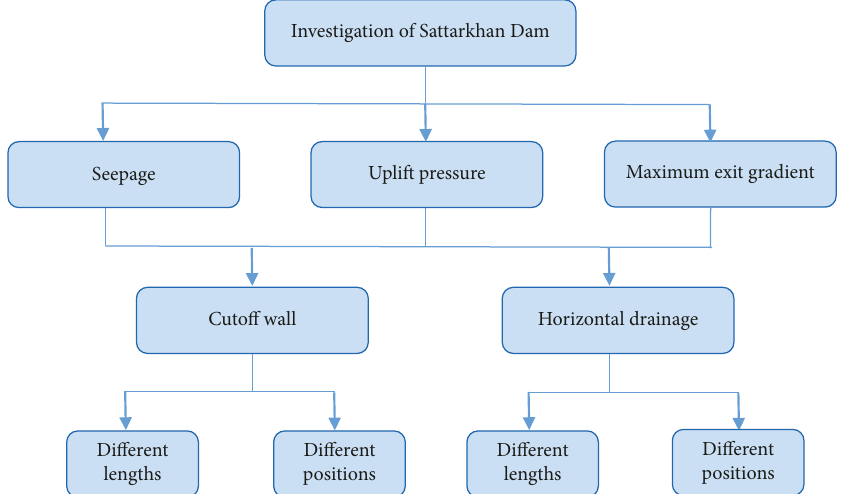
Figure 1: General structure of the